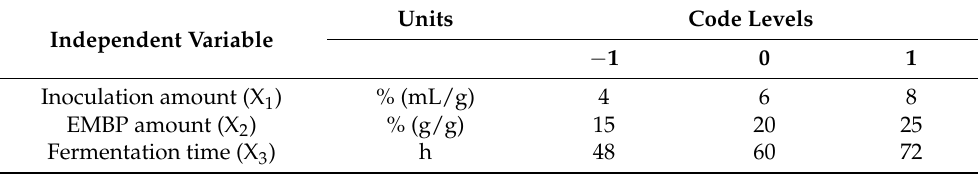
Table 1. Box–Behnken